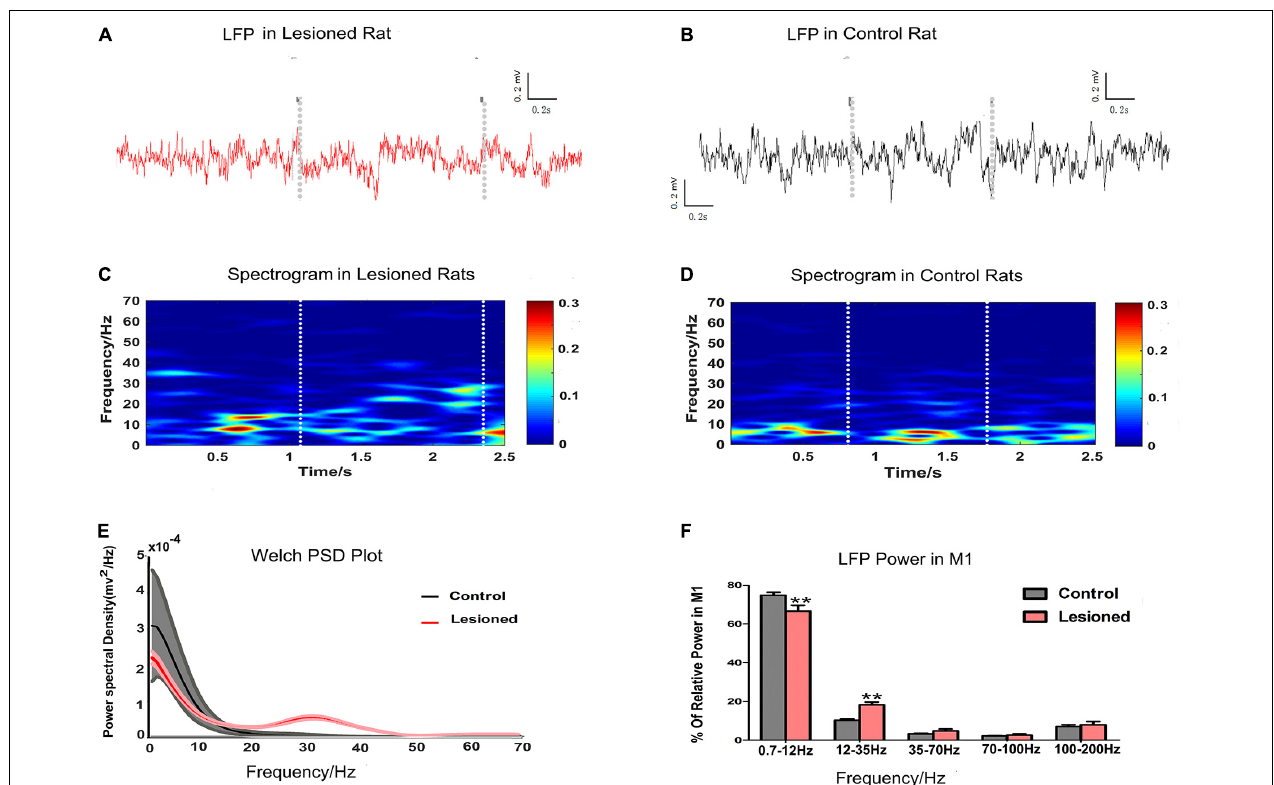
FIGURE 8 | Illustration of the impact of DA cell loss on LFP activities during the grabbing food movement. Representative examples of raw LFP recordings in M1 during catching food, with the two gray vertical dotted lines representing the periods of successful reach from 6-OHDA-treated d rat (plotted in red trace, A ) and control rat (plotted in black trace, B ). With limitations in the two white vertical dotted lines indicating the periods of successful reach, mean spectrograms of LFP power show depletion rats ( n = 14 rats, C ) and control rats ( n = 13 rats, D ). The color scale is logarithmic with respect to greater spectral power illustrated in red color. The frequency distribution of the LFP calculated by Welch estimation were averaged over all sessions in control (black line, n = 13 rats) vs. depletion rats (red line, n = 14 rats) (E) . Bar graphs showed the LFP power from different frequency bands in the control (black bars) and the depletion rats (red bars), which